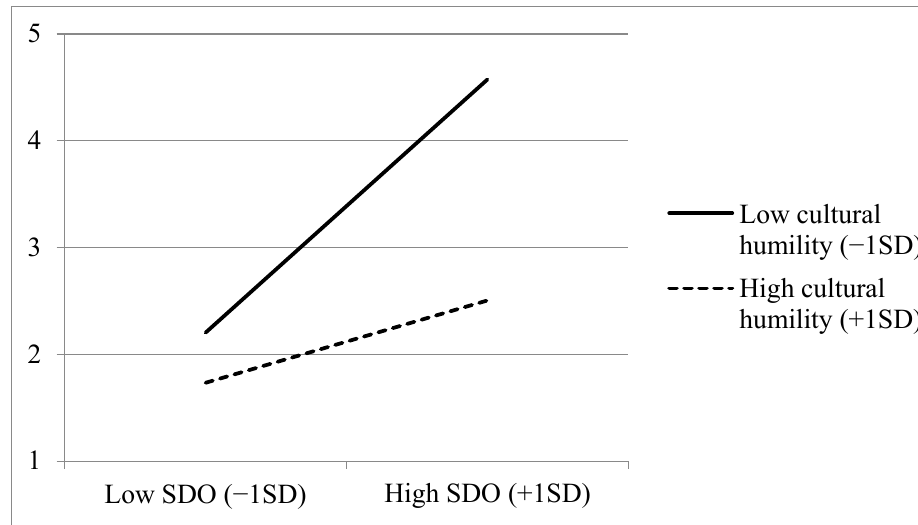
Figure 1. Prejudice as a function of social dominance orientation (SDO) and cultural humility .